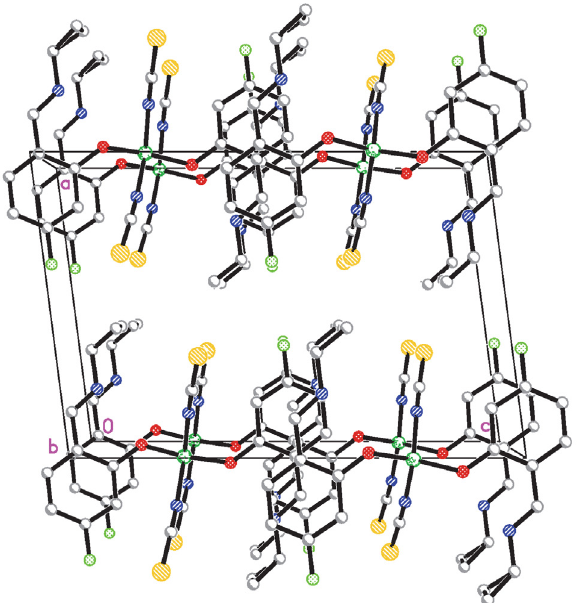
Figure 4. Molecular packing structure of complex 2 .